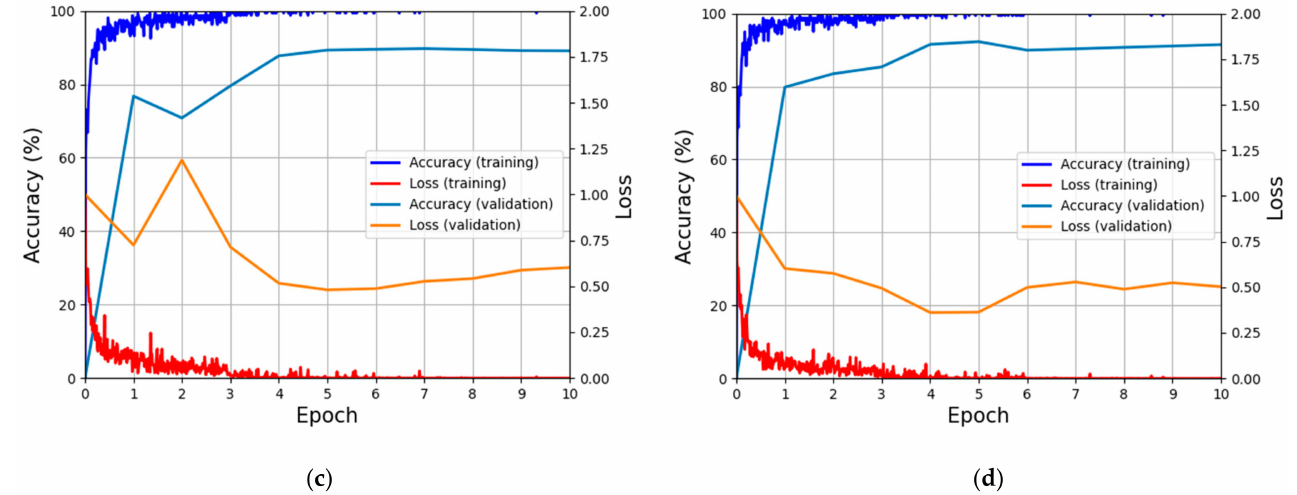
Figure 9. Training, validation loss, and accuracy graphs with SYSU-MM01 dataset. ( a , b ) are training and validation graphs of the original DenseNet for ( a ) fold 1 and ( b ) fold 2. ( c ) and ( d ) are training and validation graphs of the attention-guided DenseNet for ( c ) fold 1 and ( d ) fold 2.